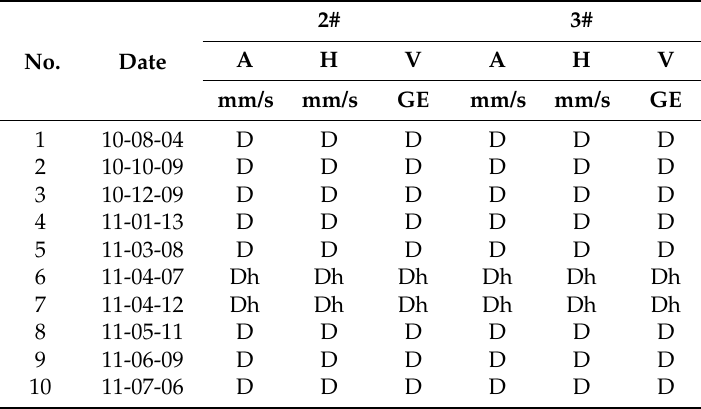
Table 1. The acquired running sensor-dependent vibration data.